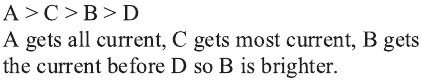
FIG. 7. Future teacher response modeling student response to posttest question (C) in Fig. 2. This was classified as ‘‘nearly correct’’ for